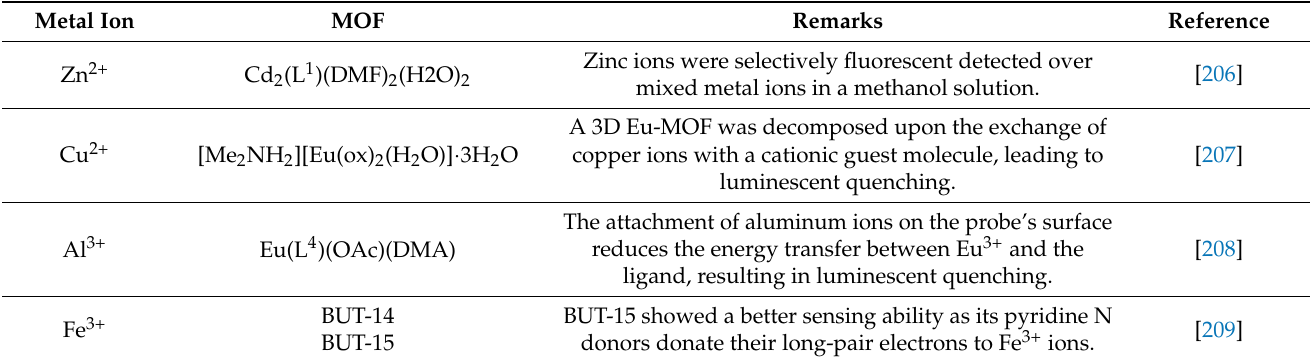
Table 5. MOFs used for the detection of metal ions related to Alzheimer’s